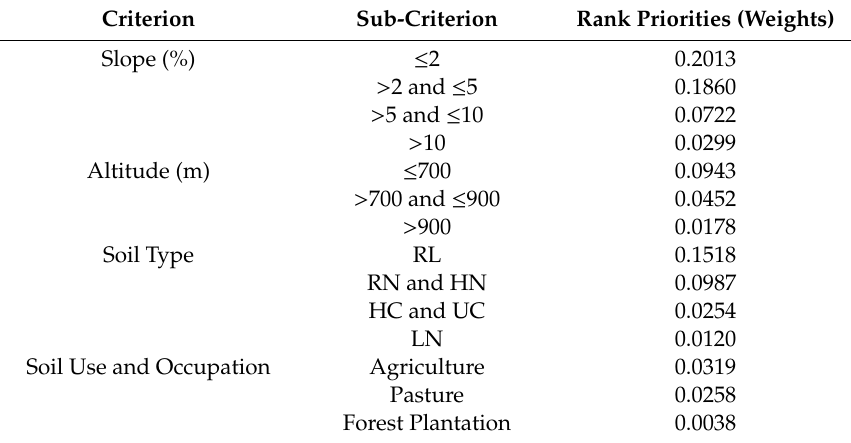
Table 8. List of classifications of the criteria and sub-criteria.